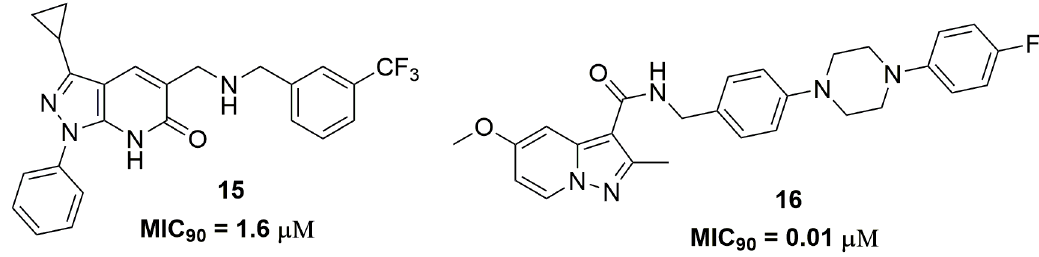
Figure 5. Compounds with antitubercular activity against MDR and extensively-drug resistant tuberculosis (XDR-TB).